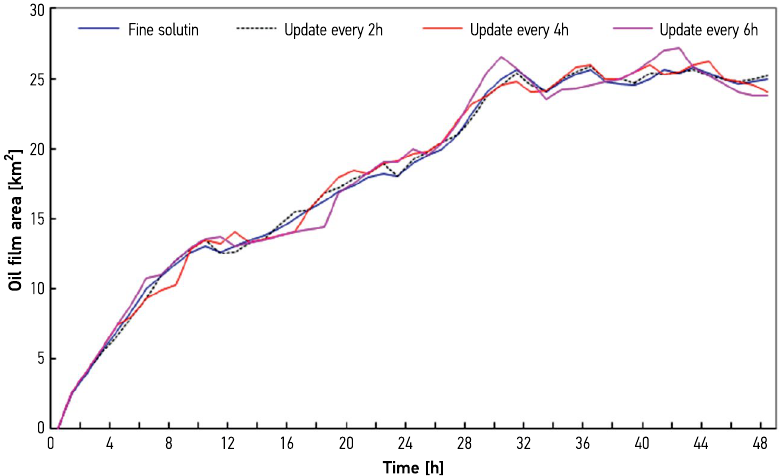
Fig. 4. Simulation results of oil film area for different updating